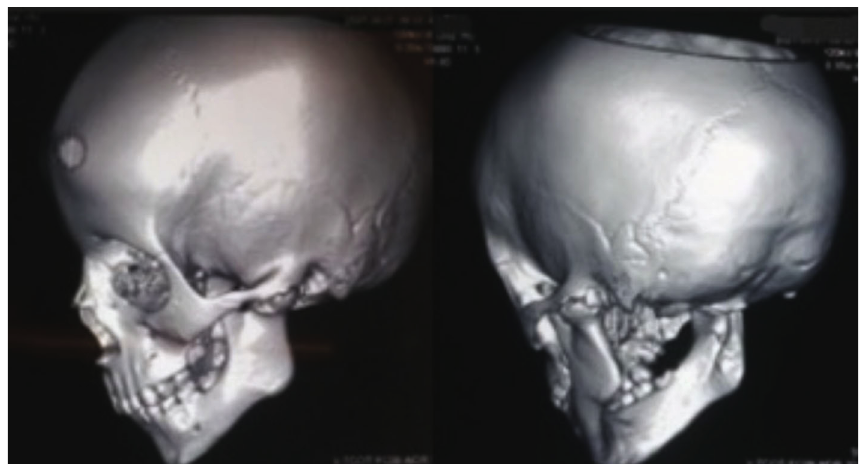
Figure 3: A 3-D reformatted CT scan of the patient showing left TMJ ankylosis and elongated left coronoid process.